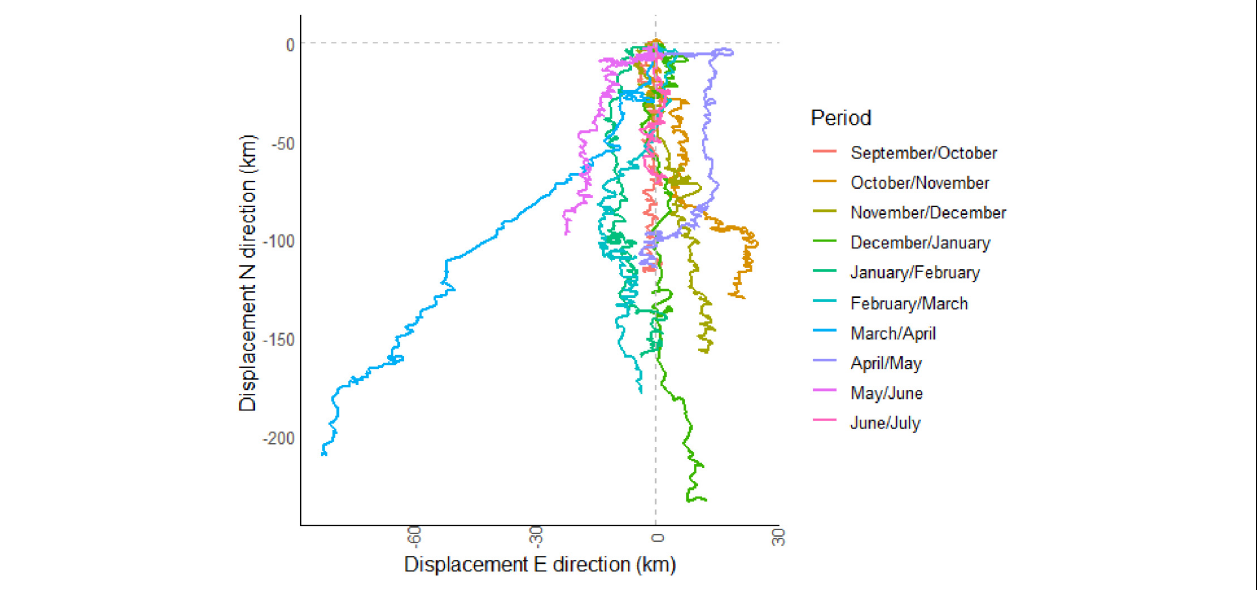
FIGURE 7 | Progressive vector plot of 30-day intervals, corresponding to the sampling interval of the sediment trap. The site where the passive particle was released is the coordinate 0/0, the lander site.